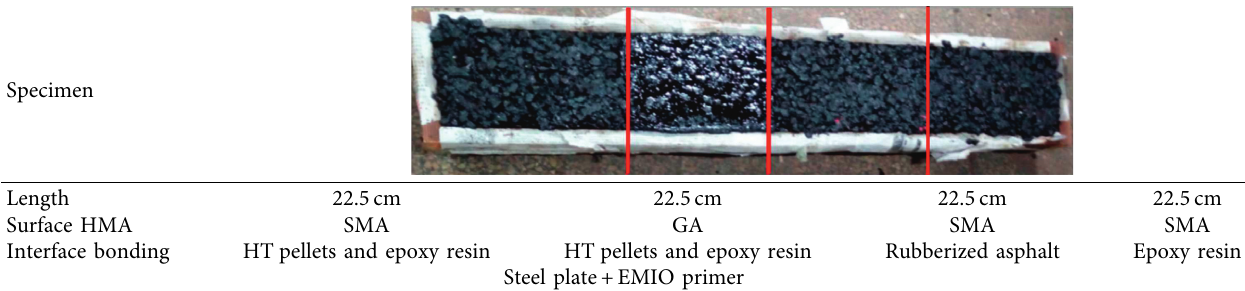
Figure 16: MMLS3 apparatus. (a) Overview. (b) Water channel for specimens. Table 4: Specimen preparation for accelerated pavement